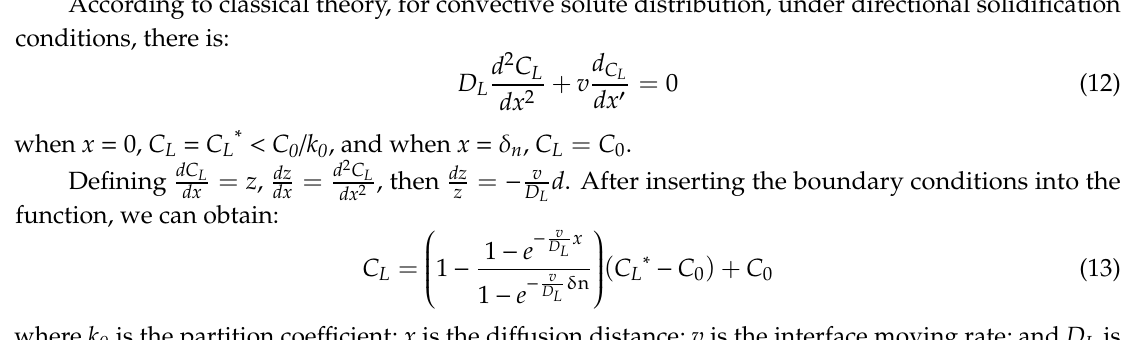
9 of 16 Figure 7. Effect of Fe content on grain size: ( a ) 0Fe, ( b ) 0.1Fe, ( c ) 0.3Fe, ( d ) 0.5Fe, ( e ) 0.7Fe, ( f ) 0.9Fe. Figure 8. The change in the average grain size with Fe content. 3.3. Element Distribution in Ti–6Al–4V–xFe Alloy As shown in Figure 9, the Fe composition distribution along the green lines was obtained and demonstrated in Figure 9e. As the Fe content increased from Figure 9a to d, the maximum solute concentration C L * of Fe in the liquid phase at the solid–liquid boundary continued to rise (here represented by mass fraction), which were 0.67, 1.12, 1.48, and 1.63 wt%, respectively, corresponding to the four peaks in Figure 9e. The segregation ratio S